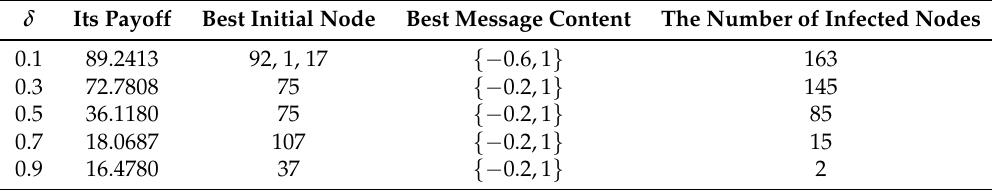
Table 9. Only player 2 forwarding its message to the